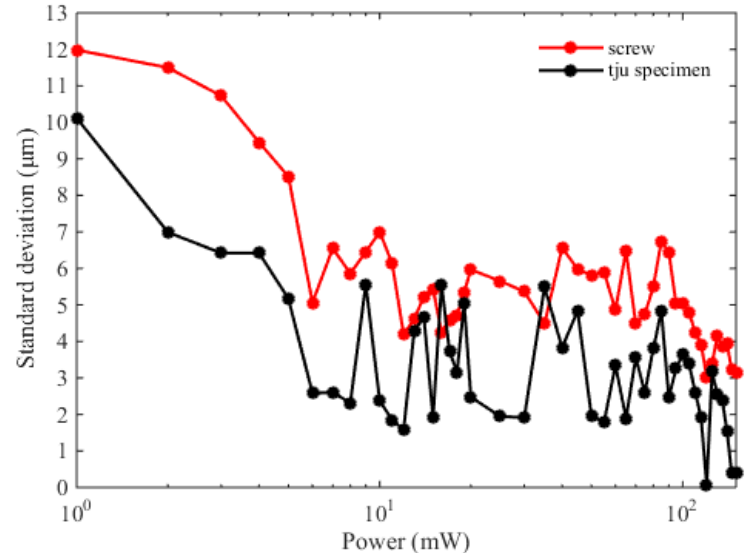
Figure 5. Standard deviations with different irradiation power. The black solid points indicate the standard deviation with five measurements, for the tju specimen, and the red solid points show the standard deviation for the screw.